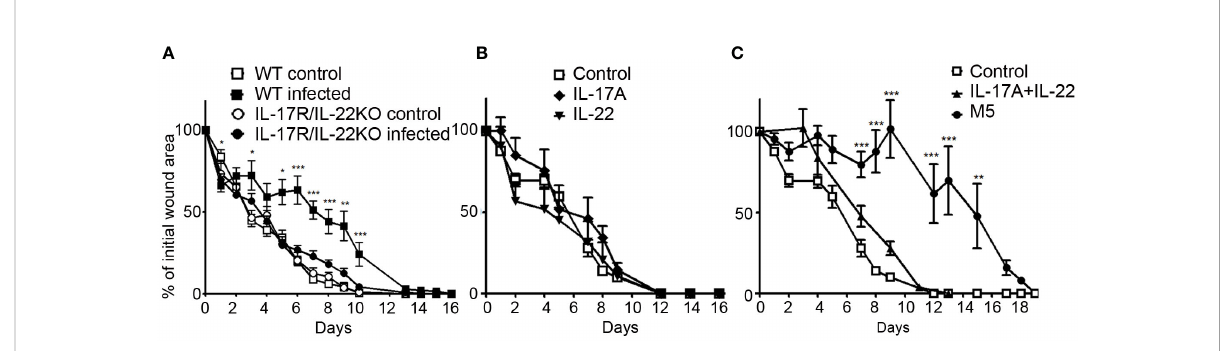
FIGURE 3 Combination of IL-17 and IL-22 are required for delayed closure in an infected skin wound. Time course of wound closure expressed as the percentage of initial wound area at each time point, (A) in the uninfected or infected wounds of WT mice (control □ ; infected ■ ) or IL-17R/IL- 22KO mice (control ○ ; infected ● ). (B) in the uninfected wound of WT mice injected with IL-17A ( ♦ ), IL-22 ( ▼ ). (C) in the uninfected wound of WT mice injected with IL-17A and IL-22 ( ▲ ), mix of IL-17A, OSM, TNF a , IL-22 and IL-1 a ( ● ) or PBS as a control ( □ ). The data are expressed as the mean +/- SEM of 5 independent experiments, with at least 4 mice/group. * p <0.05, ** p <0.01, *** p